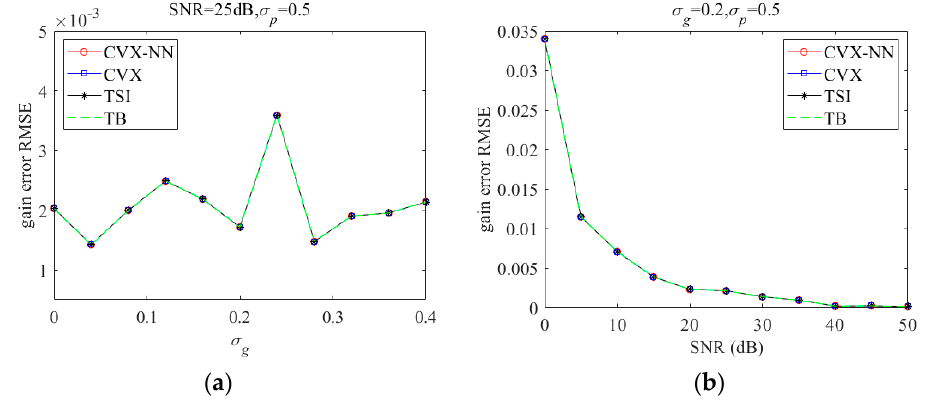
Figure 8. Estimated gain error RMSE versus SNR and σ g : ( a ) versus σ g ; ( b ) versus SNR.